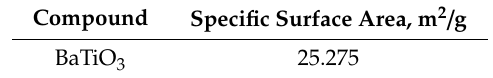
Table 2. The specific surface area of BaTiO 3 after 90 min of the synthesis proceeded in a ball mill.